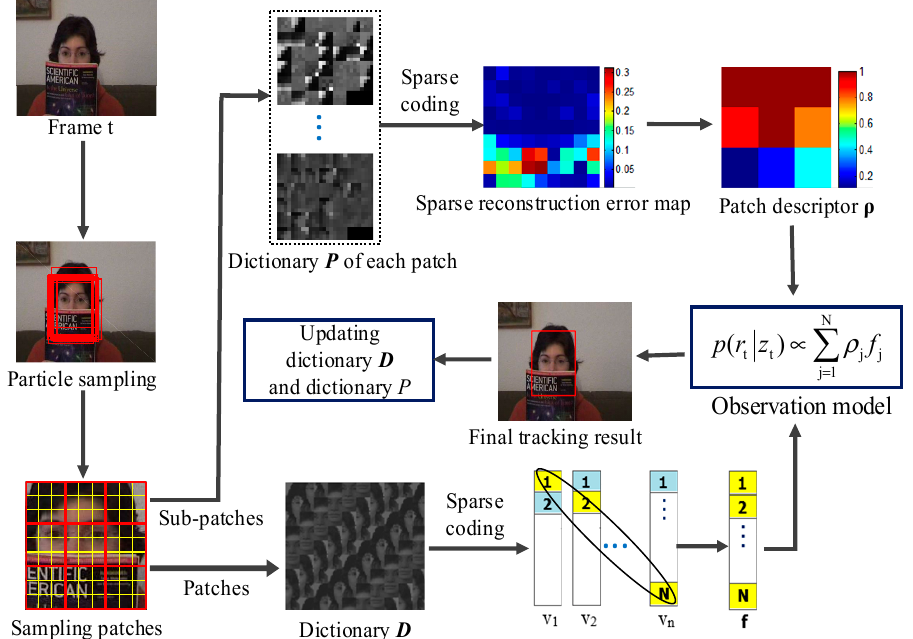
Figure 2. Schematic diagram of the proposed tracking method.